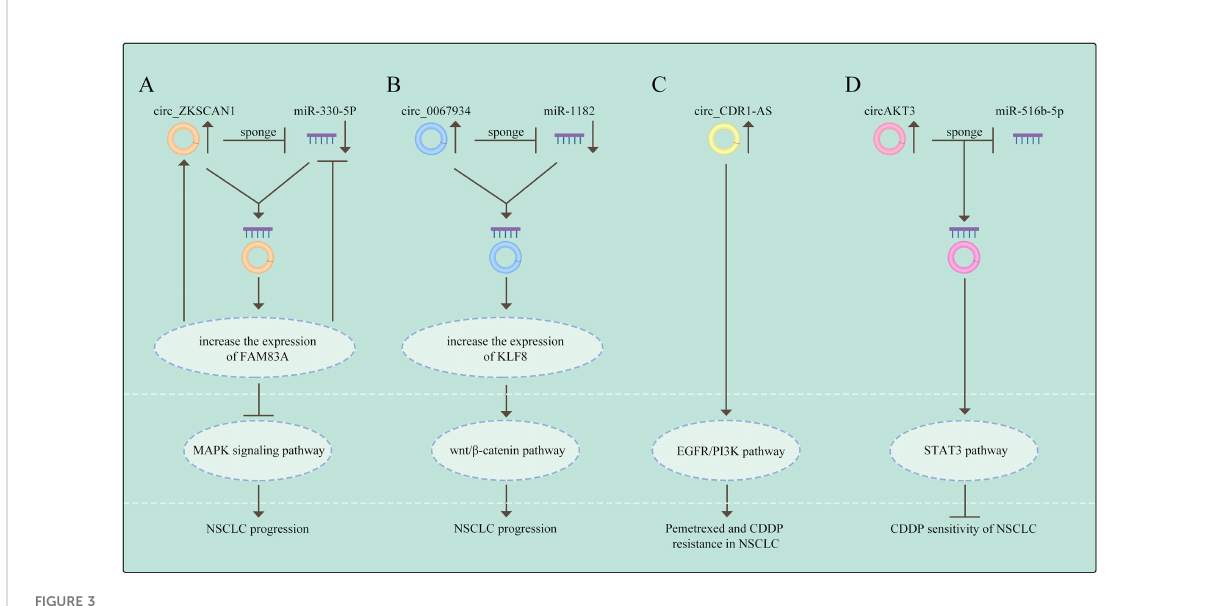
FIGURE 3 The relationship between signaling pathways and circRNAs in NSCLC (A) Circ_ZKSCAN1 sponges miR-330-5p to increase the expression of FAM83A, resulting in the inhibition of MAPK signaling pathway, thus promoting the progress of NSCLC. (B) Circ_0067934 promotes NSCLC development by regulating miR-1182/KLF8 axis and activating Wnt/ b -catenin pathway. (C) CircRNA CDR1-AS contributes to pemetrexe and cisplatin resistance via the EGFR/PI3K signaling pathway. (D) CircAKT3 regulates cisplatin resistance of NSCLC via modulating STAT3 by sponging miR-516b-5p. The meaning of " → " is "promote", and "T" is